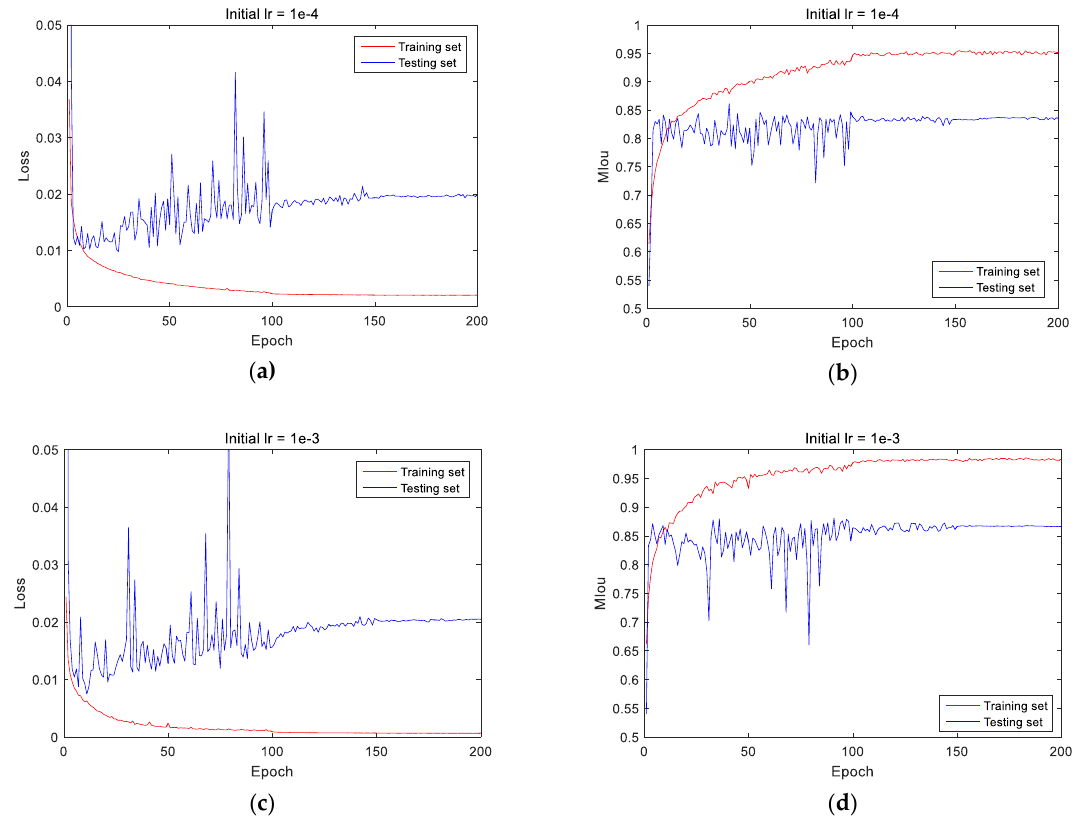
Figure 11. Loss and MIoU (mean intersection over union) curve after decreasing learning rate are adopted, ( a ) and ( b ) are the loss and MIoU curve when the initial learning rate is 10 −4 , ( c ) and ( d ) are the loss and MIoU curve when the initial learning rate is 10 −3 .